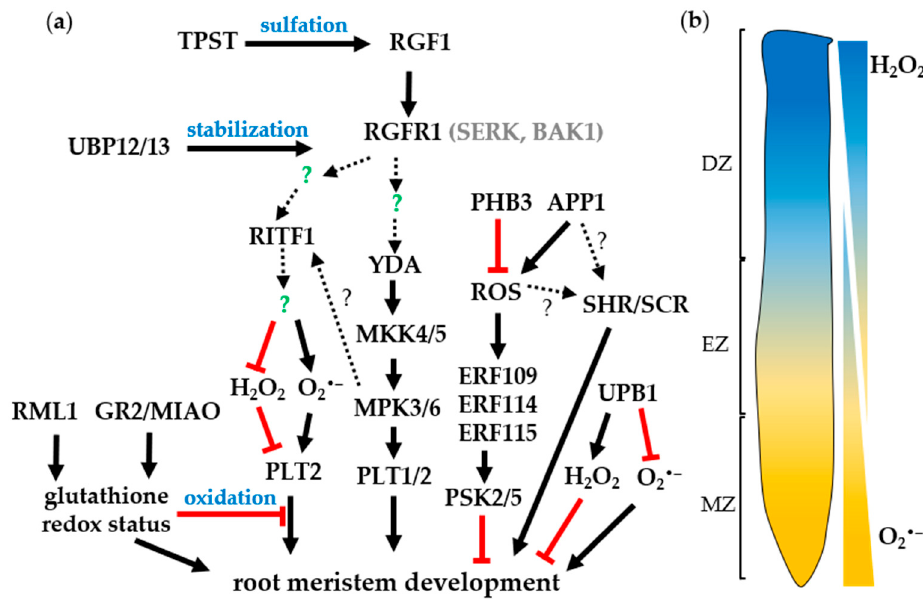
Figure 2. The signaling cascade of ( a ) RGF1-RGI1 and ROS signals to regulate root meristem development. SERK and BAK1 act as co-receptors for RGI1. Arrows indicate positive regulation; red bars mean negative regulation; green question marks indicate unknown players; and broken lines with question marks represent further experiments are needed. ( b ) The H 2 O